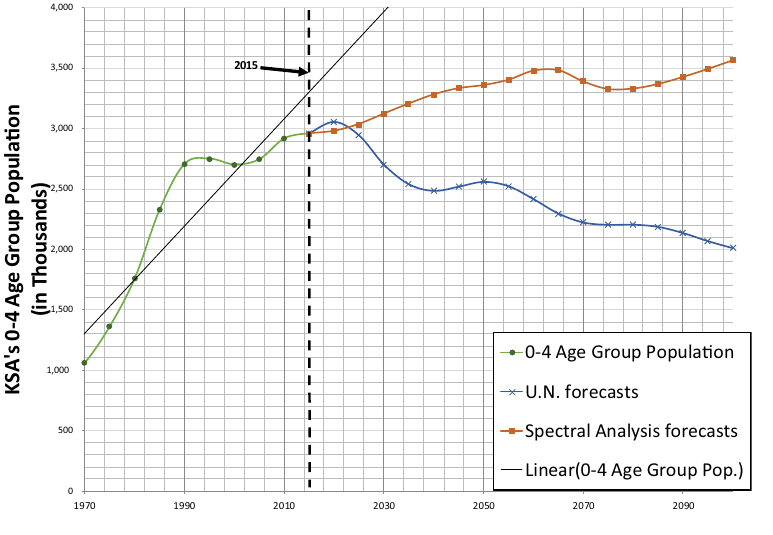
Figure 8. 0-4 age group population; population forecasted with spectral analysis versus population projection (medium variant) of the